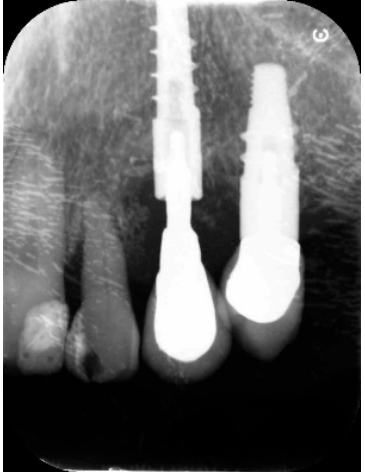
Figure 5. ( a ) Clinical image immediately after decontamination. ( b ) Repositioning of the mucoperiosteal flap.